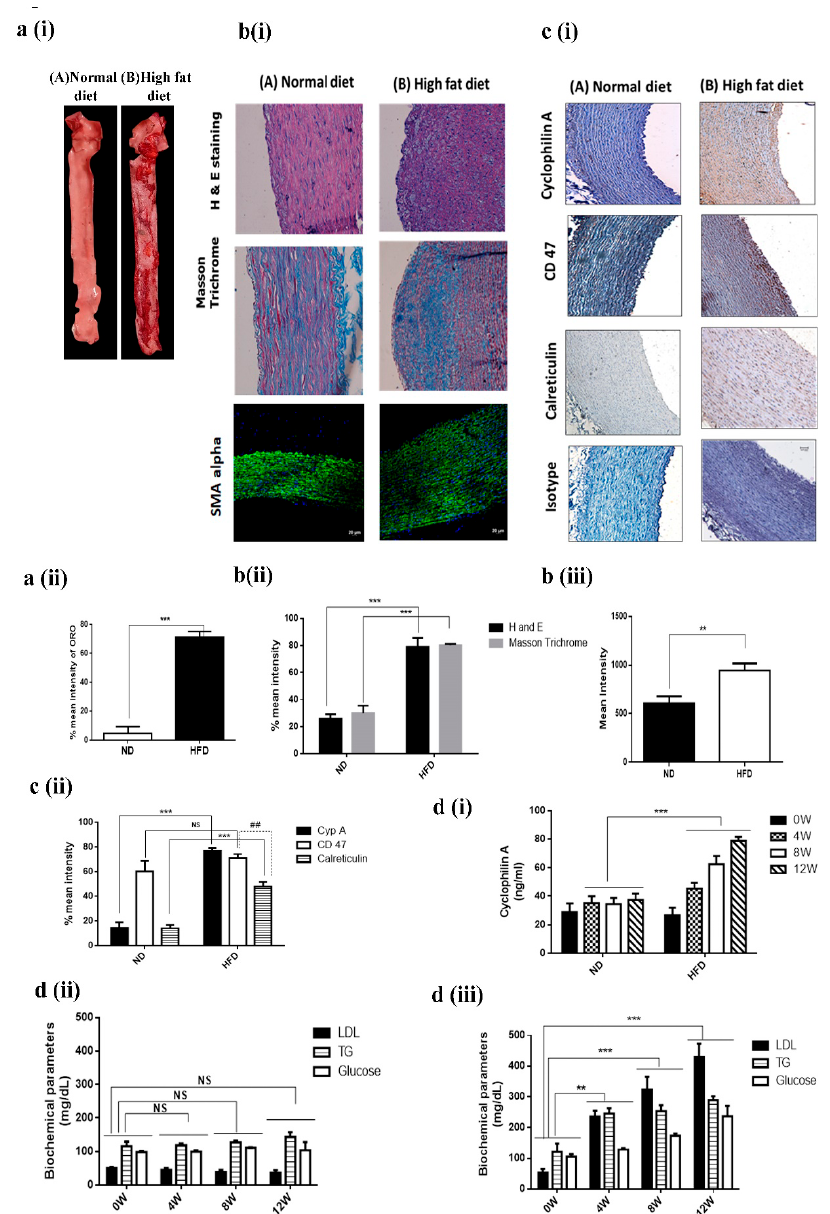
Figure 4. CD 47 and plasma cyclophilin A levels were increased in HFD-fed New Zealand white rabbit. ( a ) (i and ii). ORO staining of rabbit aorta. ( b ) (i and ii). Histological analysis of the cross sections from the aortic arch of HFD- and ND-fed rabbit after staining with H&E staining and Masson Trichrome. ( b ) (i and iii). Confocal images of the expression of α - smooth muscle cell actin ( α -SMA) of the cross sections from the aortic arch of HFD- and ND-fed rabbit; ( c ) (i and ii). Immunohistochemical staining of cross sections from the aortic arch of HFD- and ND-fed rabbit after staining with Cyp A, CD 47 and calreticulin. ( d ) Mean values of (i) plasma cyclophilin A level and biochemical parameters in the study groups. (ii) ND group; (iii) HFD group. Levels of plasma Cyp A, along with serum glucose, triglyceride and LDL, were increased in animals fed HFD compared to animals fed ND; ** p < 0.01, *** p < 0.001 was considered significant (HFD group vs ND group). ## p < 0.01was considered significant (CD 47 vs Calreticulin in HFD group). The data were compared using one-way ANOVA, followed by multiple-comparison test using an SNK